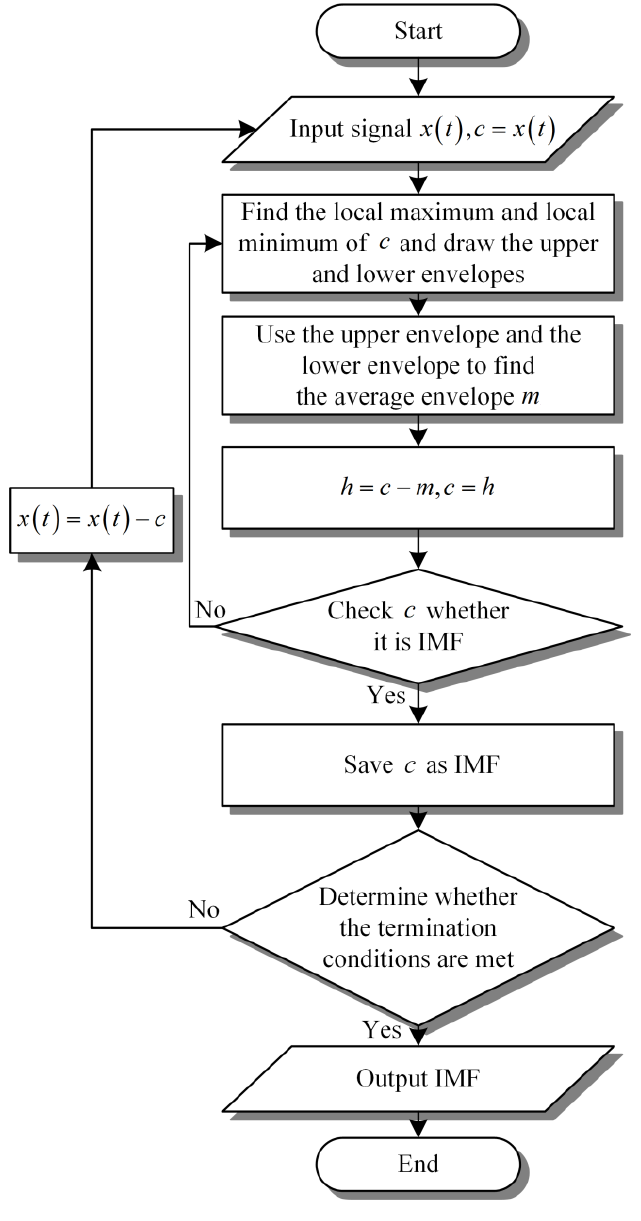
Figure 1. The flow chart of EMD.